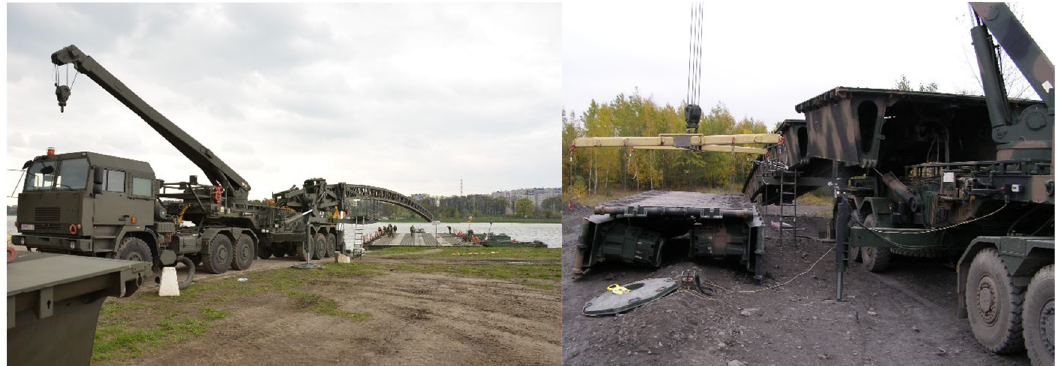
Figure 4: A vehicle with an MS - 40 launching